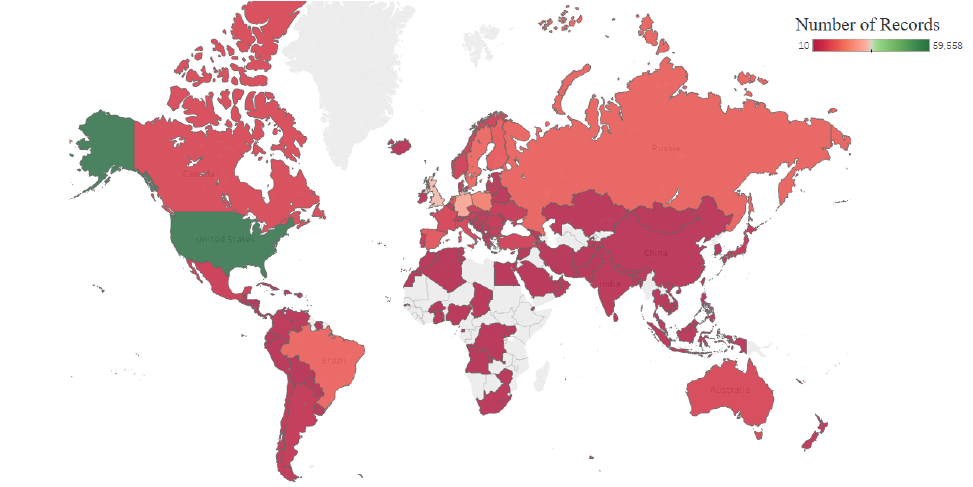
Figure 9. LastFM distribution of the records on the